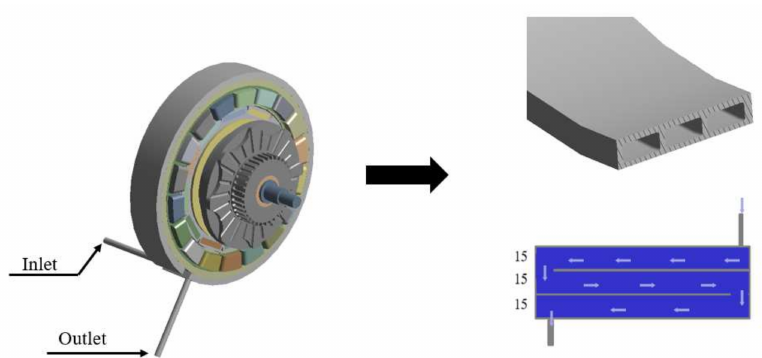
Figure 1. Geometry of 25 kW in-wheel driving motor.